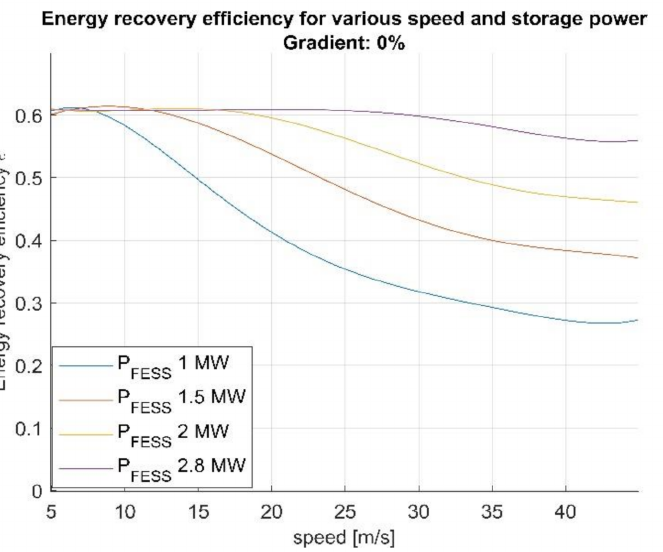
Figure 6. No gradient energy recovery efficiency for multiple top speeds and FESS powers.